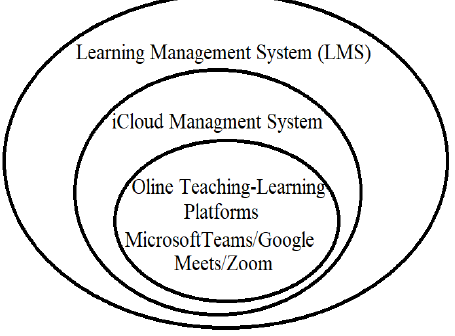
Figure 5. Learners adopted Online T-L Process